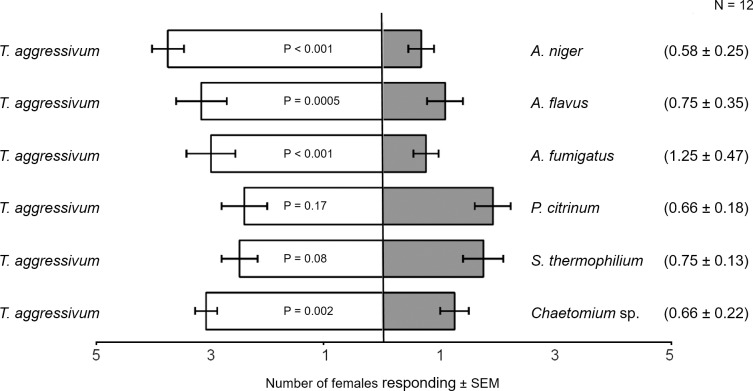
Two-choice attraction assays.Mean number (± SEM) of two-day-old gravid female Lycoriella ingenua flies attracted to various pure fungal cultures grown on potato dextrose agar in two-choice, static-flow olfactometer assays. Each horizontal bar is the mean of responses of 5 females to each treatment over 12 replicates (N = 12). The mean number of non-responders (± SEM) for each combination is included in parentheses to the right. Female choices for each pair of cultures were analyzed via chi square. All non-responders were excluded from the analysis.